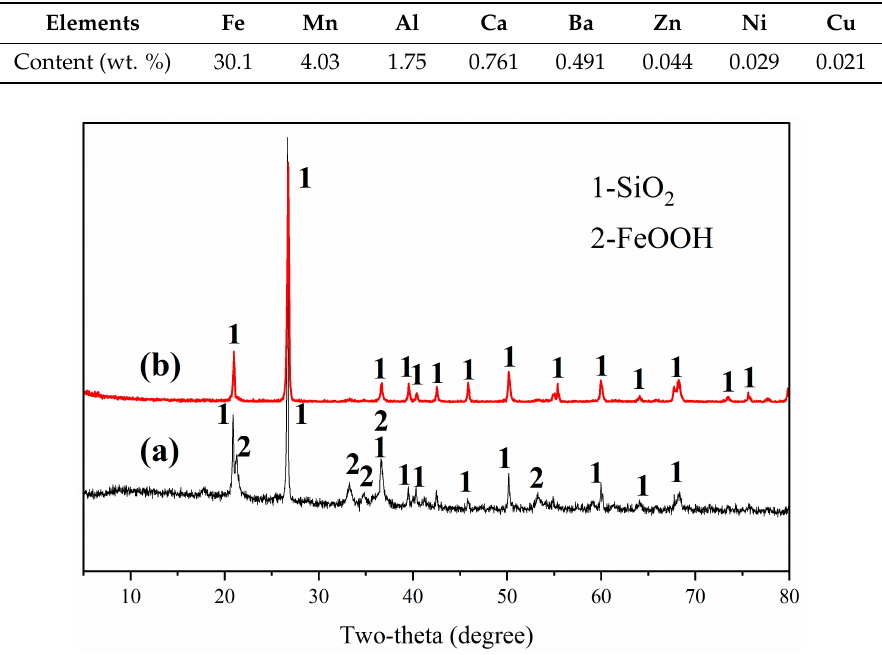
Table 1. Chemical composition (metal content) of the pyrolusite absorption residue (PAR) used for experiments.